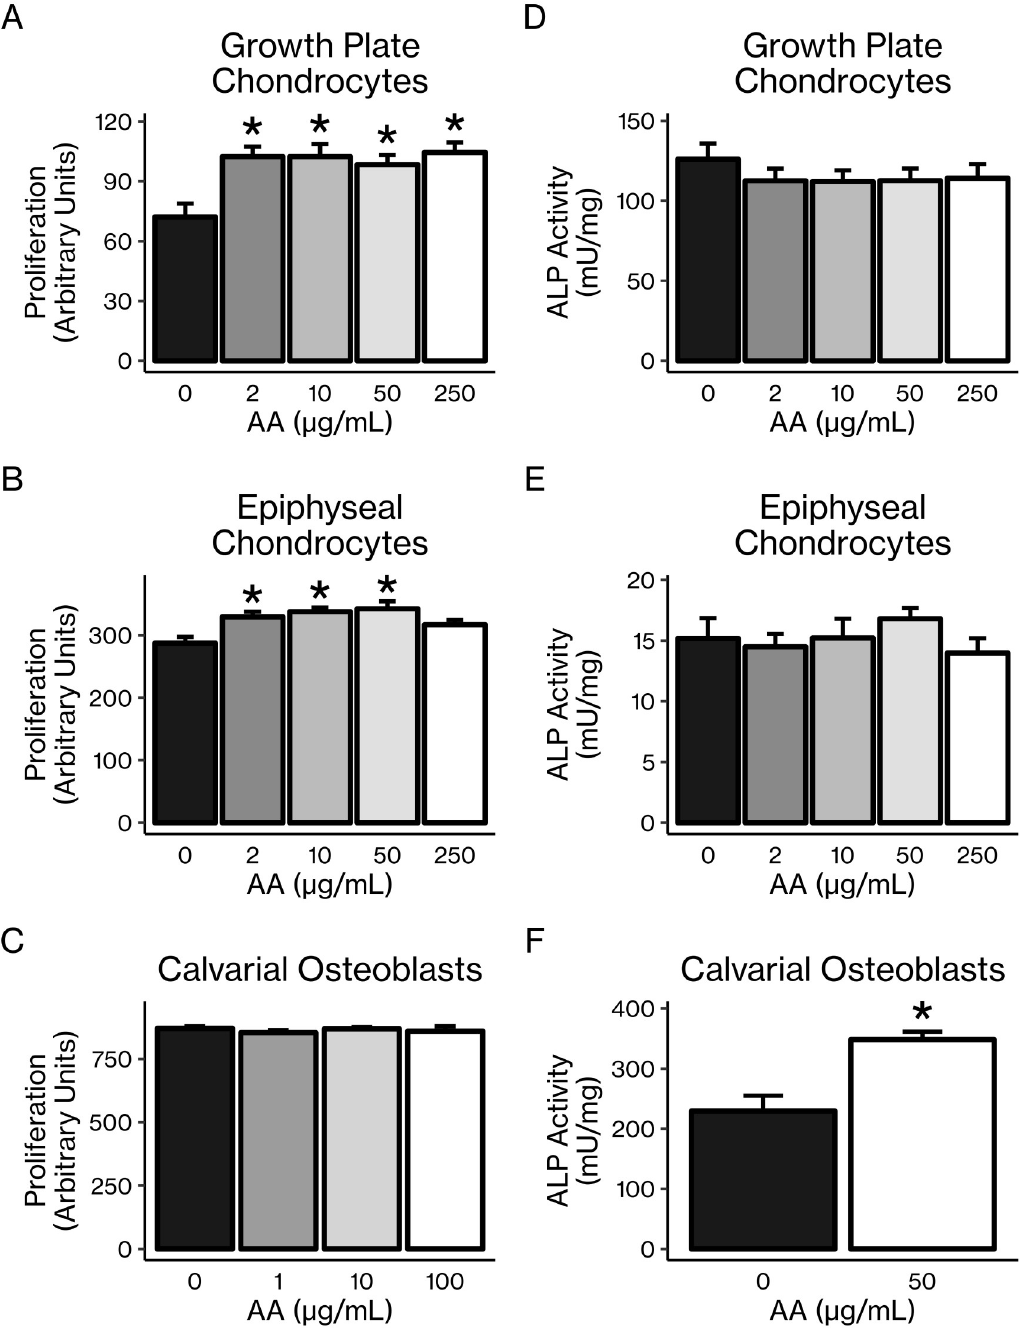
Fig 3. AA increased proliferation of primary chondrocytes and differentiation of osteoblasts in vitro . Proliferation of primary (A) growth plate chondrocytes and (B) epiphyseal chondrocytes was increased by AA treatment. Proliferation of (C) primary calvarial osteoblasts was unaffected by AA treatment. ALP activity of (D) growth plate chondrocytes and (E) epiphyseal chondrocytes was not changed by AA treatment, while ALP activity of (F) calvarial osteoblasts was increased by AA treatment. Results are presented as mean ± SEM. � P < 0.05 vs. control (pairwise t -tests with Bonferroni corrections for multiple comparisons [A–E] or Student’s t -test [F]), n = 6–8 per group.